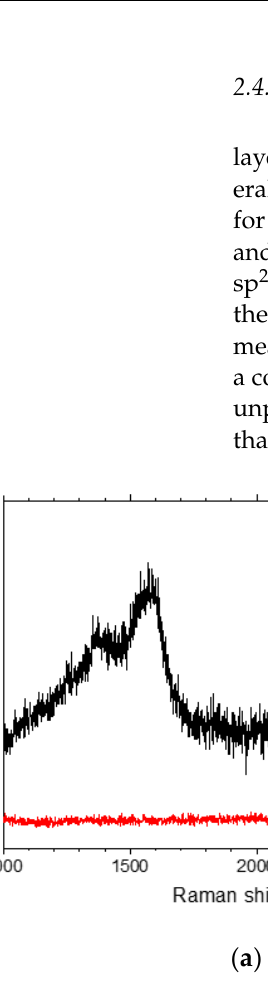
( b ) Figure 7. Map made on the basis of Raman spectra collected for a sample deposited at 900 °C ( a ) and 1000 °C ( b ). 2